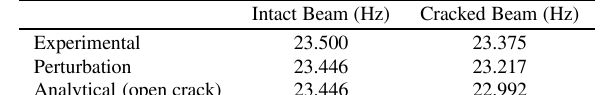
Table 1 A compression between measured and predicted 1st natural frequency of the cracked cantilever beam with α = 0.38 and β = 0.8